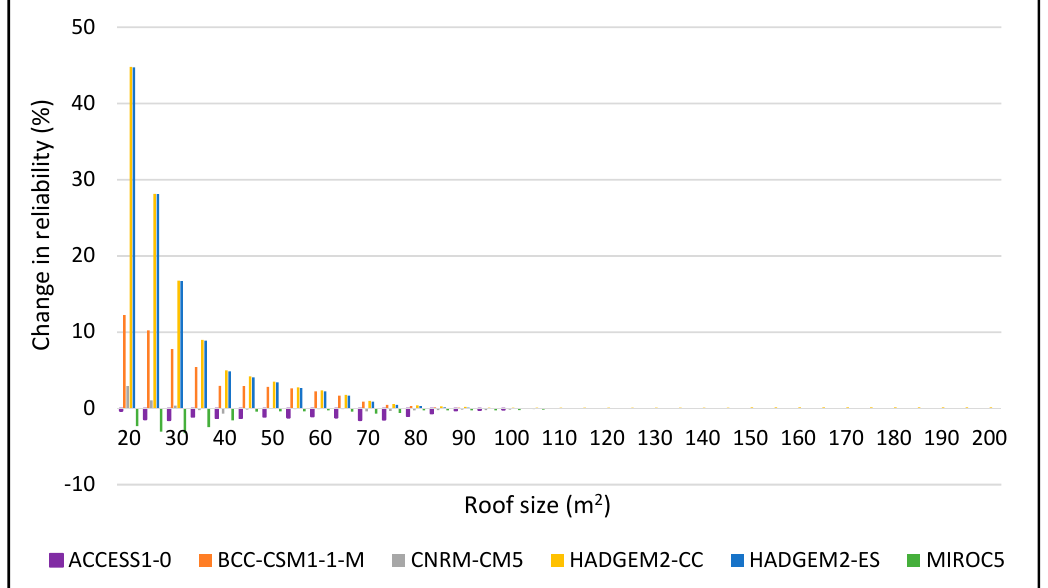
Figure 34. Change in reliability for SON season for 2060–2090 period for 2 m 3 tank.